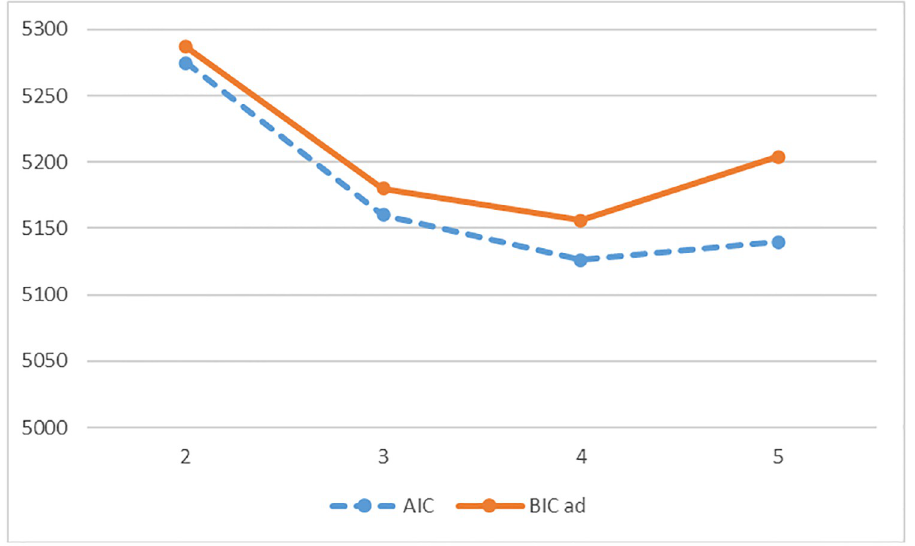
Fig 1. LCA elbow plot on AIC and aBIC of wave 1 well-being at